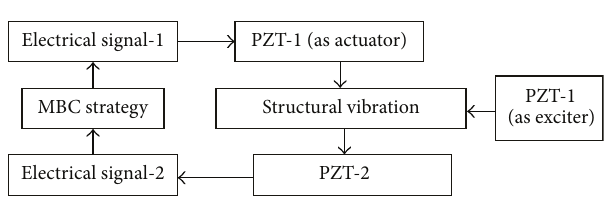
Figure 2: Experimental program.